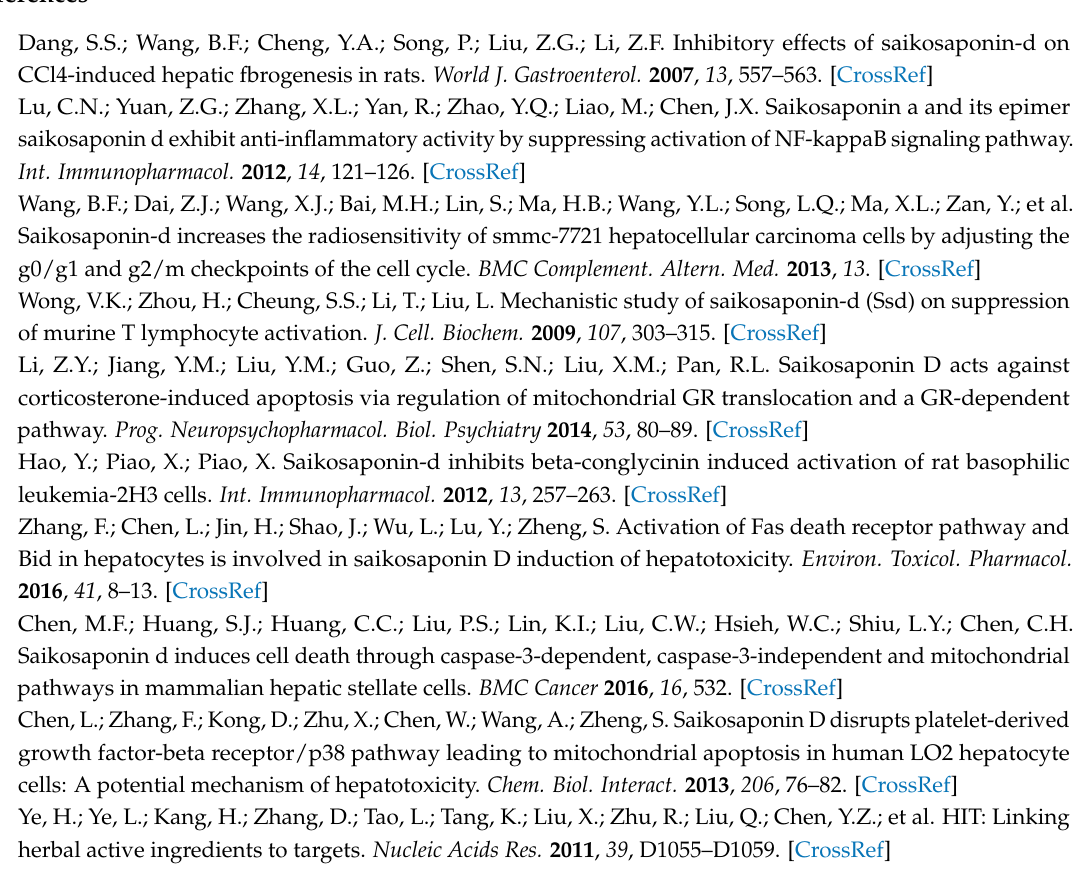
Supplementary Materials: The following are available online: Figure S1: The intersection of targets amount SSd treatment; Table S1: Potential targets of SSd searched by databases; Table S2: Targets obtained by literature mining; Table S3: Targets and its active compounds predicted by SSd and its structural analogues in Pubchem; Table S4: All the predicted targets of SSd; Table S5: Statistical parameters of the models; Table S6: Differential metabolites relevant to both NRP-1 knockdown and SSd treatment; Table S7: Differential metabolites related to NRP-1 knockdown; Table S8: Differential metabolites related to SSd